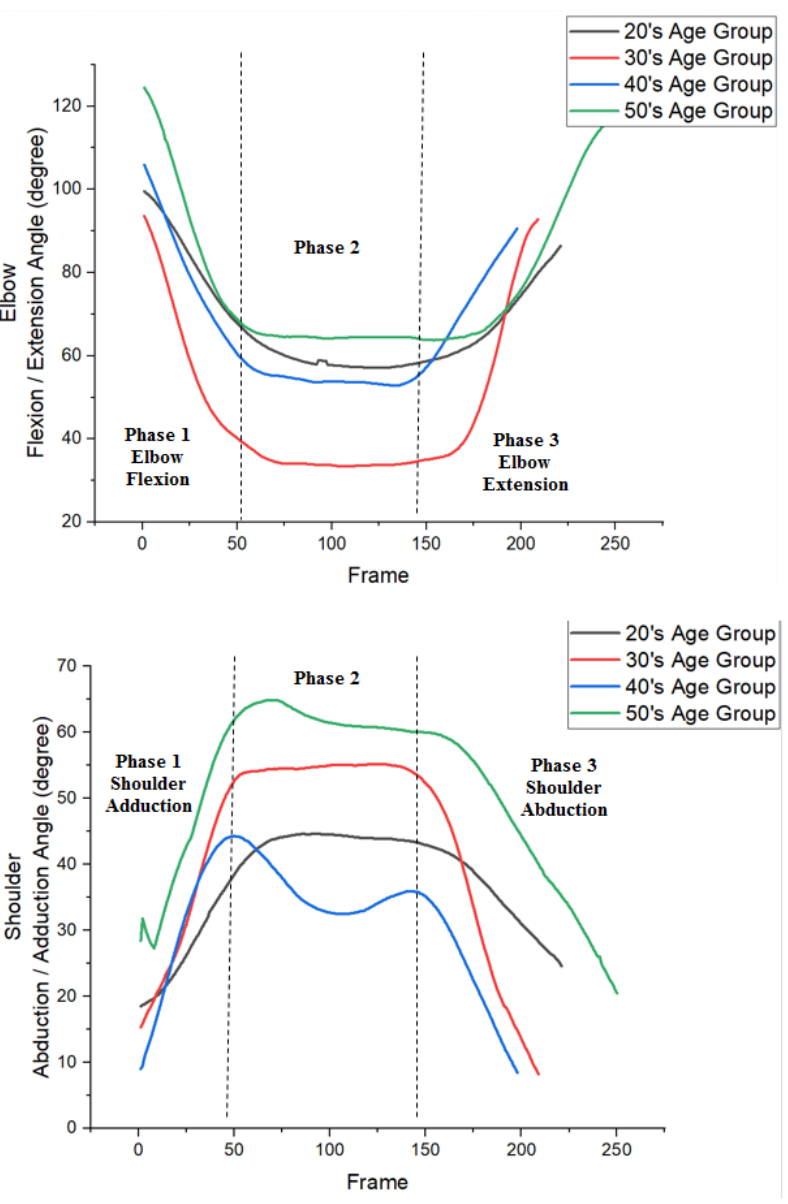
Figure 4. Angles for shoulder and elbow during touching of contralateral shoulder for normal sub- ject.